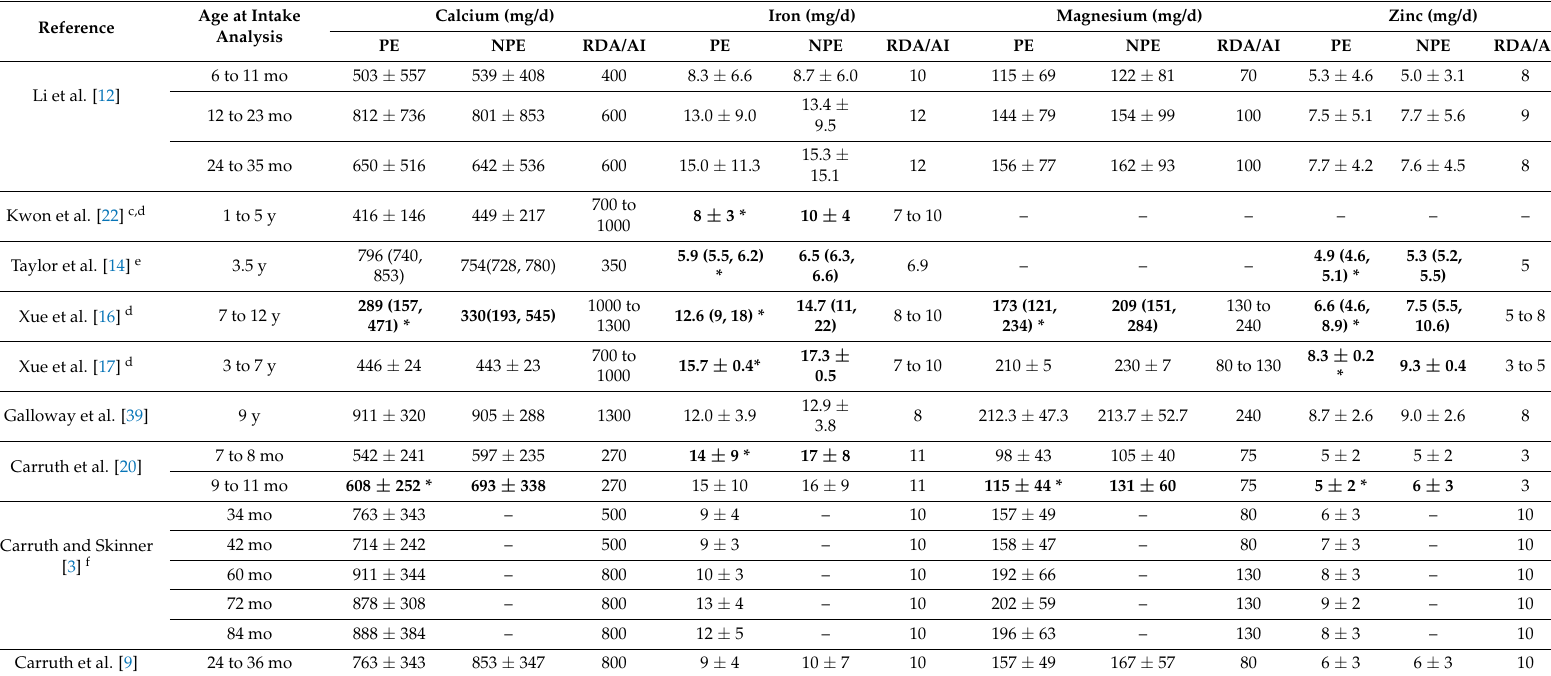
Table 8. Intakes of Minerals in PE and NPE a,b